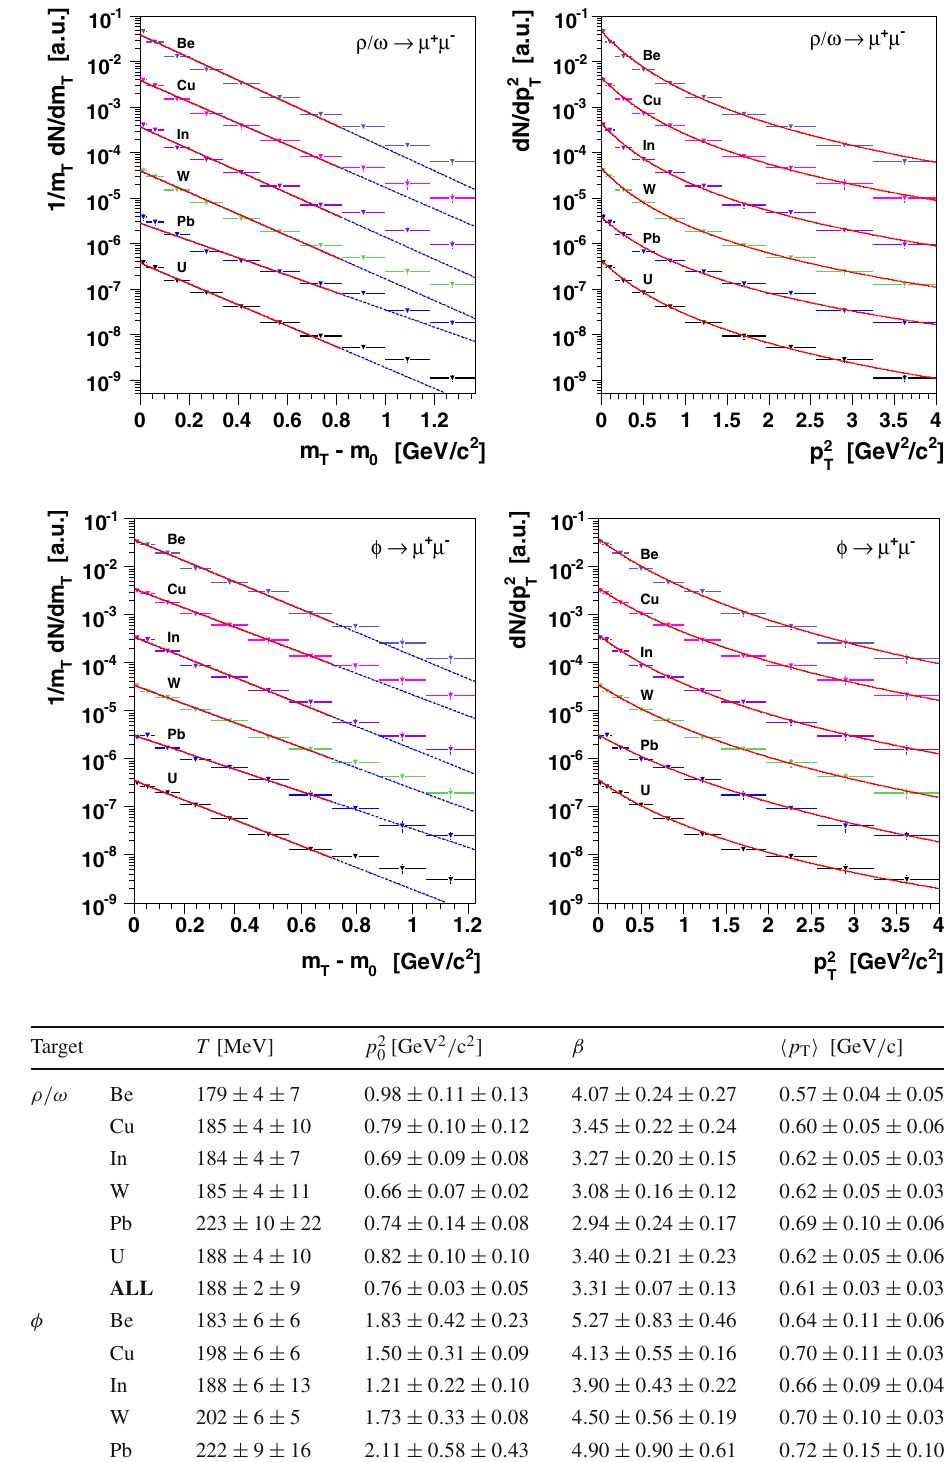
Table 1 Results for the ρ/ω and φ transverse momentum spectra as a function of A: T -values as obtained from thermal functions; p 2 , β and 0 (cid:9) p (cid:10) as obtained from the T power-law fit